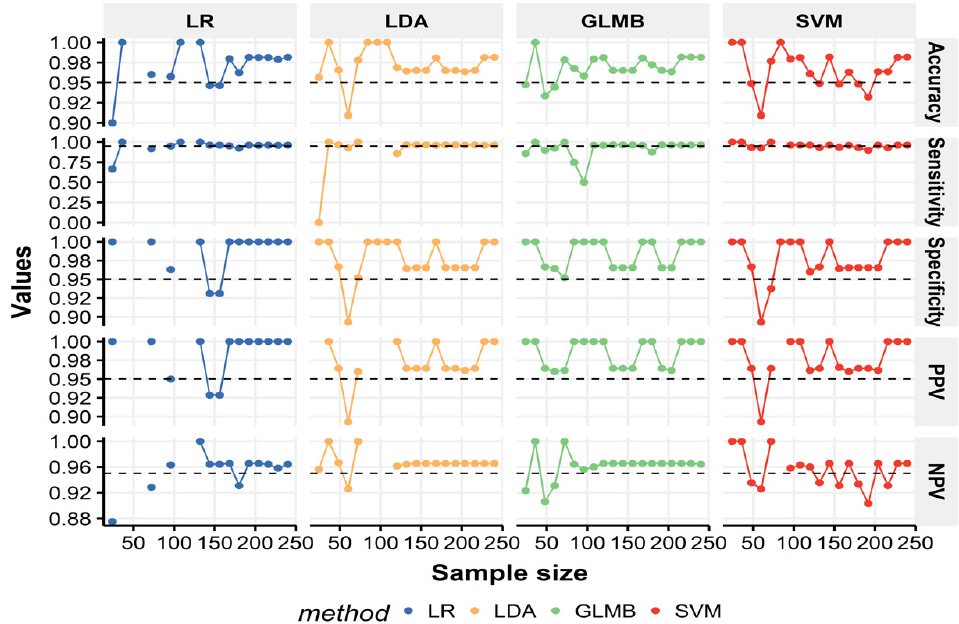
Figure 3. Influence of the training sample size on the classification performance parameters in the testing sample ( n = 60). It should be noted that multivariate models were computed using the variable selection procedure. The interrupted line delineates the desired level of 95%.